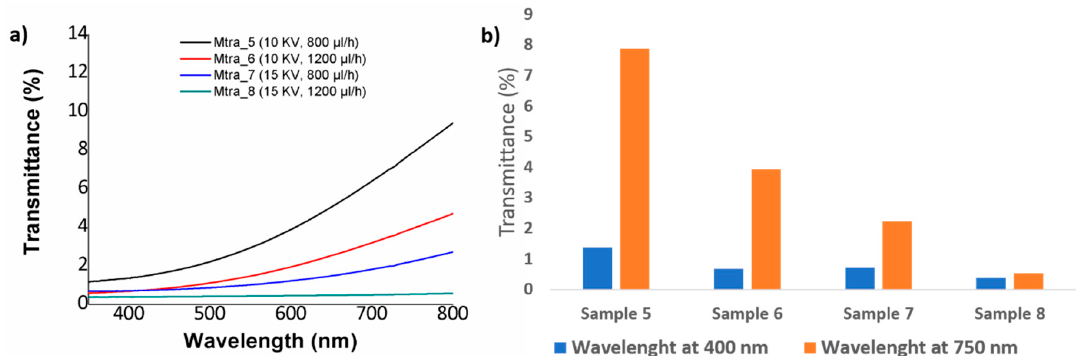
Figure 7. ( a ) UV–vis spectra of the resultant PVC fibers for a fixed polymeric concentration of 10 wt % as a function of the applied voltage (10 or 15 KV) and flow rate (800 or 1200 µL); ( b ) Transmittance change at a specific wavelength of the visible region at 400 nm and 700 nm, respectively.